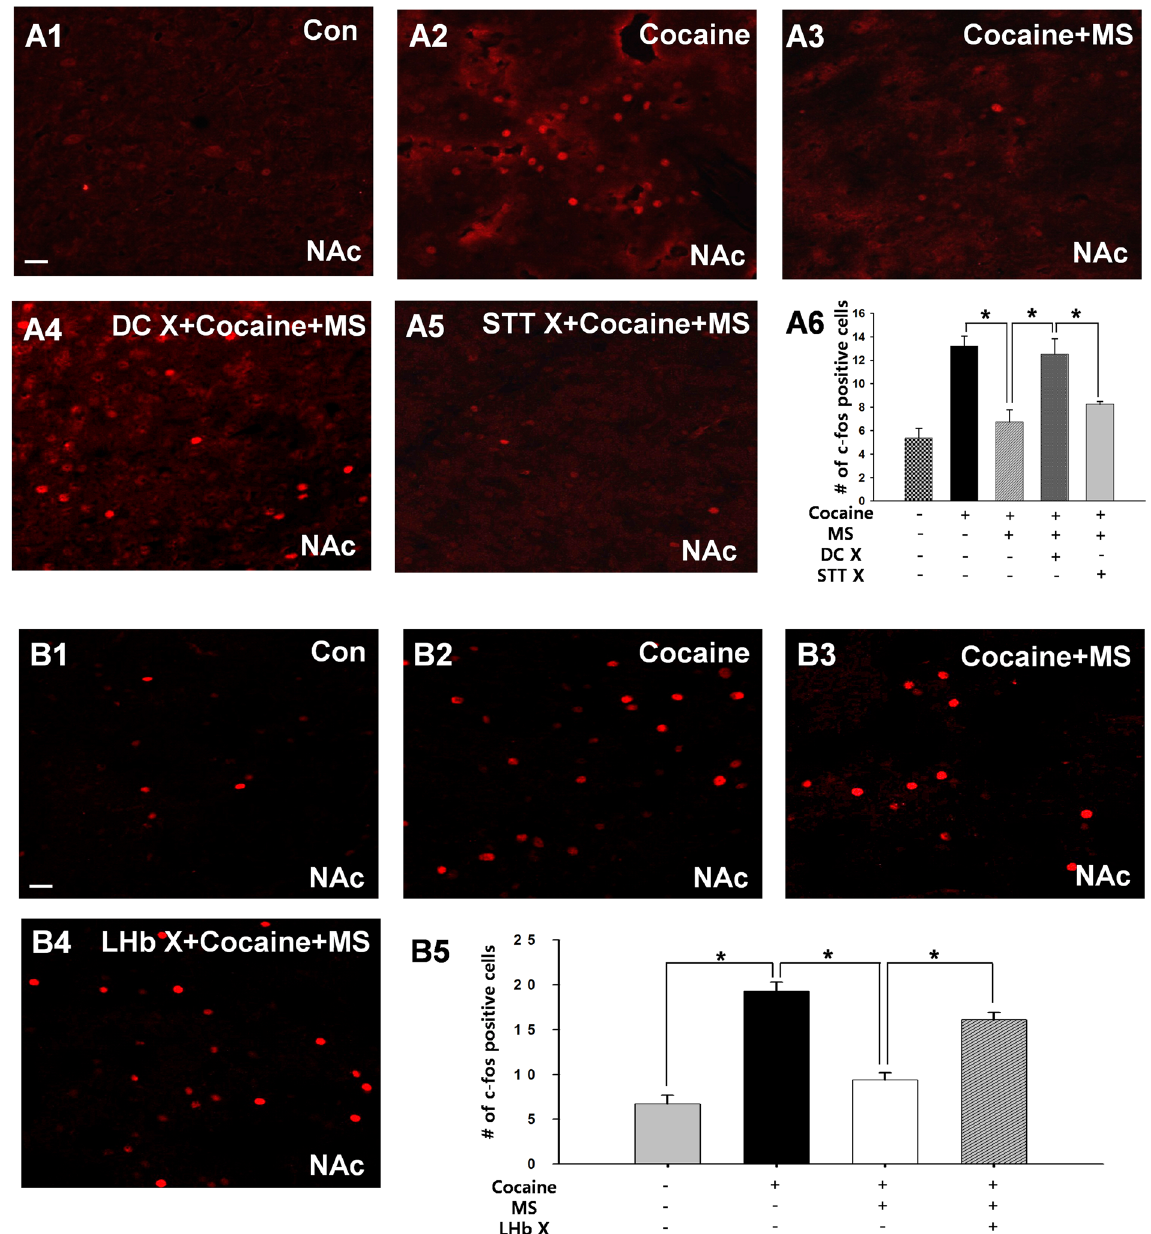
Figure 6. The effects of DC or LHb lesions on ulnar inhibition of cocaine-induced c-fos expression in the NAc. ( A ) The cocaine-induced increase in c-fos positive neurons in NAc (A2; Cocaine, n = 6) was attenuated by ulnar stimulation (A3; Cocaine + MS, n = 6), which was prevented when the DC was damaged (A4; DC X + Cocaine + MS, n = 6), but not STT (A5–6; STT + Cocaine + MS, n = 6). A1, control (Con); * p < 0.05, Bar = 20 µ m. ( B ) The cocaine-induced increase in c-fos positive neurons in NAc (B2; Cocaine, n = 6) was attenuated by ulnar stimulation (B3; Cocaine + MS, n = 6), which was prevented when the LHb was damaged (B4–5; LHb X + Cocaine + MS, n = 6). B1, control (Con); * p < 0.05, Bar = 20 µ